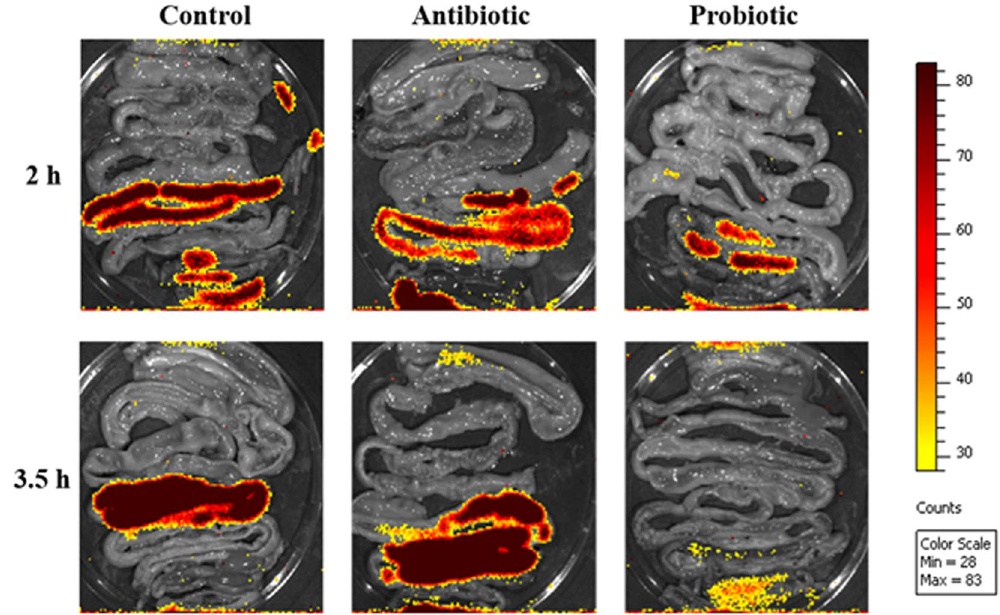
Figure 1. Bioluminescent images of isolated gastro-intestinal tracts of broilers from the different treatments groups (i.e. multi-strain probiotic, antibiotic combination and control) at 2 and 3.5 h after administration of